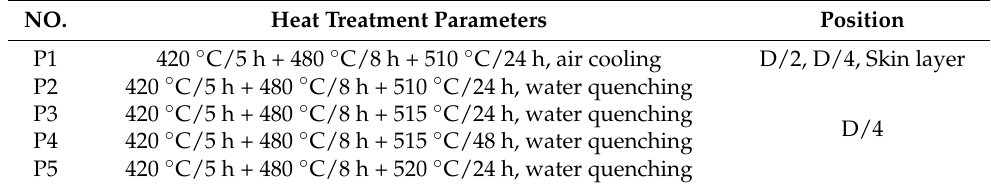
Table 2. Various homogenization heat treatment